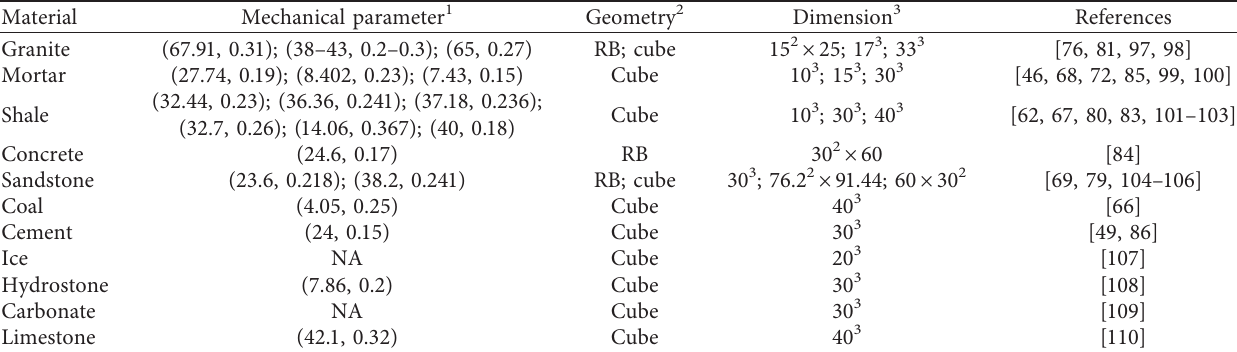
Table 2: Samples used for laboratory-scale hydraulic fracturing experiments with a true triaxial experimental